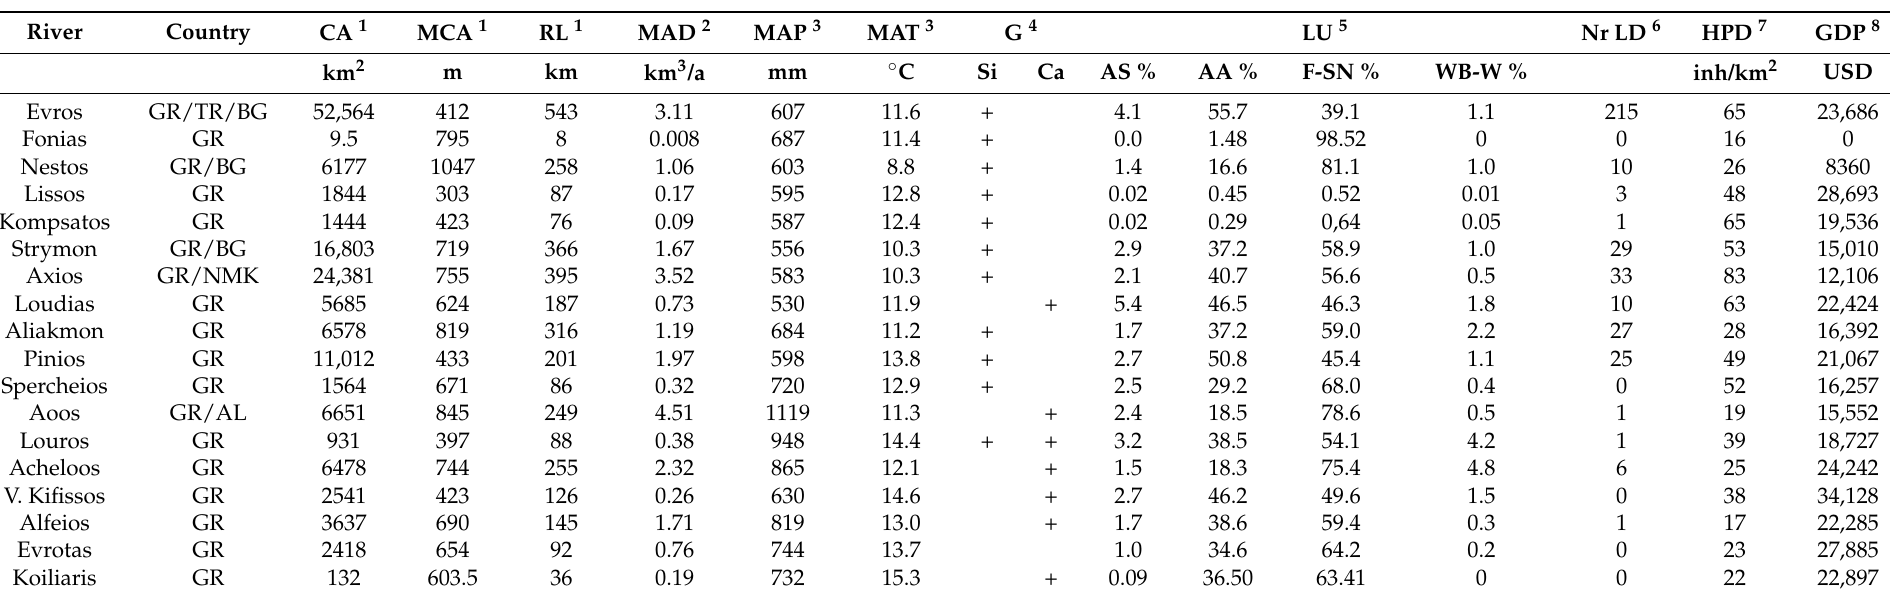
Table 1. Physicogeographical and anthropogenic characteristic of the examined river